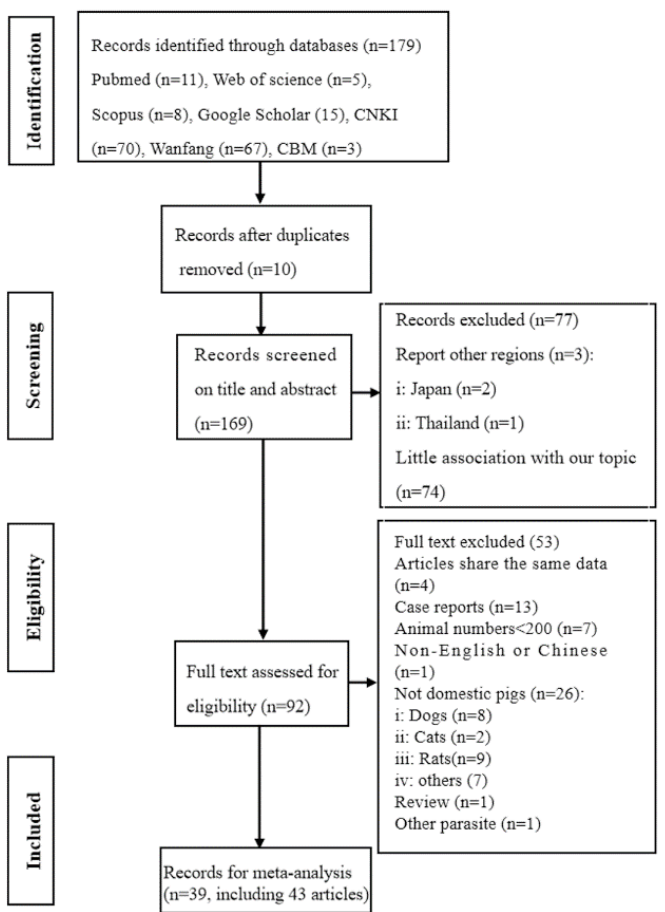
Figure 1. The flow diagram of search and selection of relevant articles for a systematic review on the prevalence of Trichinella spiralis in domestic pigs in China.